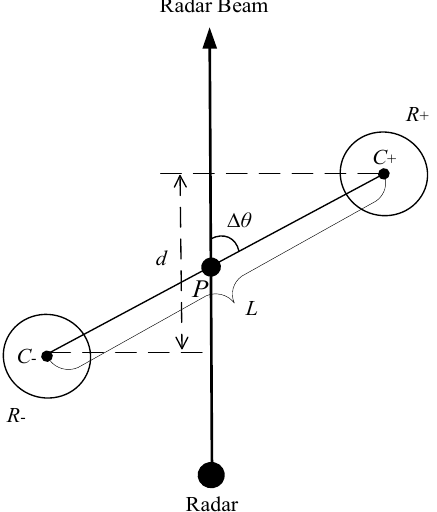
Figure 1. Velocity structures of the Meso- γ scale system: ( a ) Pure cyclonic rotation flow field. ( b ) pure anticyclonic rotation flow field, ( c ) pure convergence flow field, ( d ) pure divergence flow field, ( e ) cyclonic convergence flow field. ( f ) cyclonic divergence flow field, ( g ) anticyclonic convergence flow field, and ( h ) anticyclonic divergence flow field. The central point of each subgraph represents the center of the airflow field and the radar is located directly below the center of the airflow field. Blue ellipses represent the maximum inflow velocity centers, and red ellipses represent the maximum outflow velocity centers. Grey and black solid arrows represent the wind directions and black dashed arrows represent the radar beams.